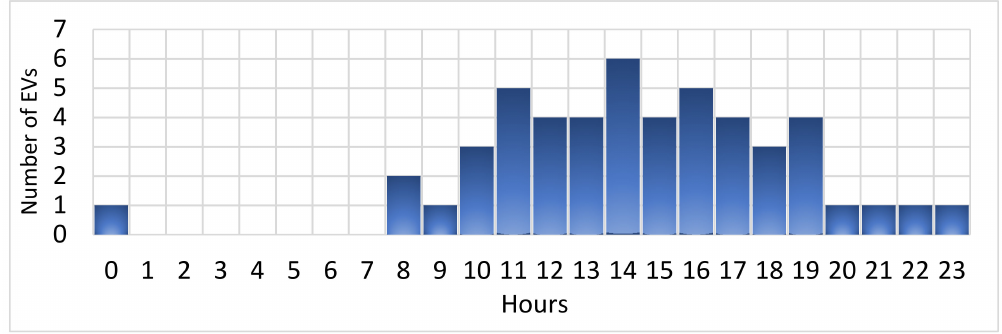
Figure 6. Stochastic EV demand